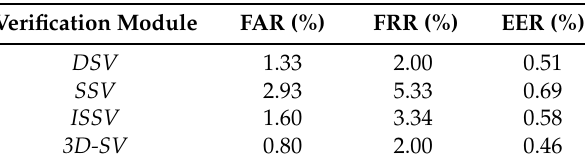
Table 3. The table shows the person independent FAR, FRR, and EER for each of the four verification modules. There are a total of 150 genuine test and 375 forged signatures. The 3D-SV module shows the best results, while the DSV module demonstrates competitive performance.